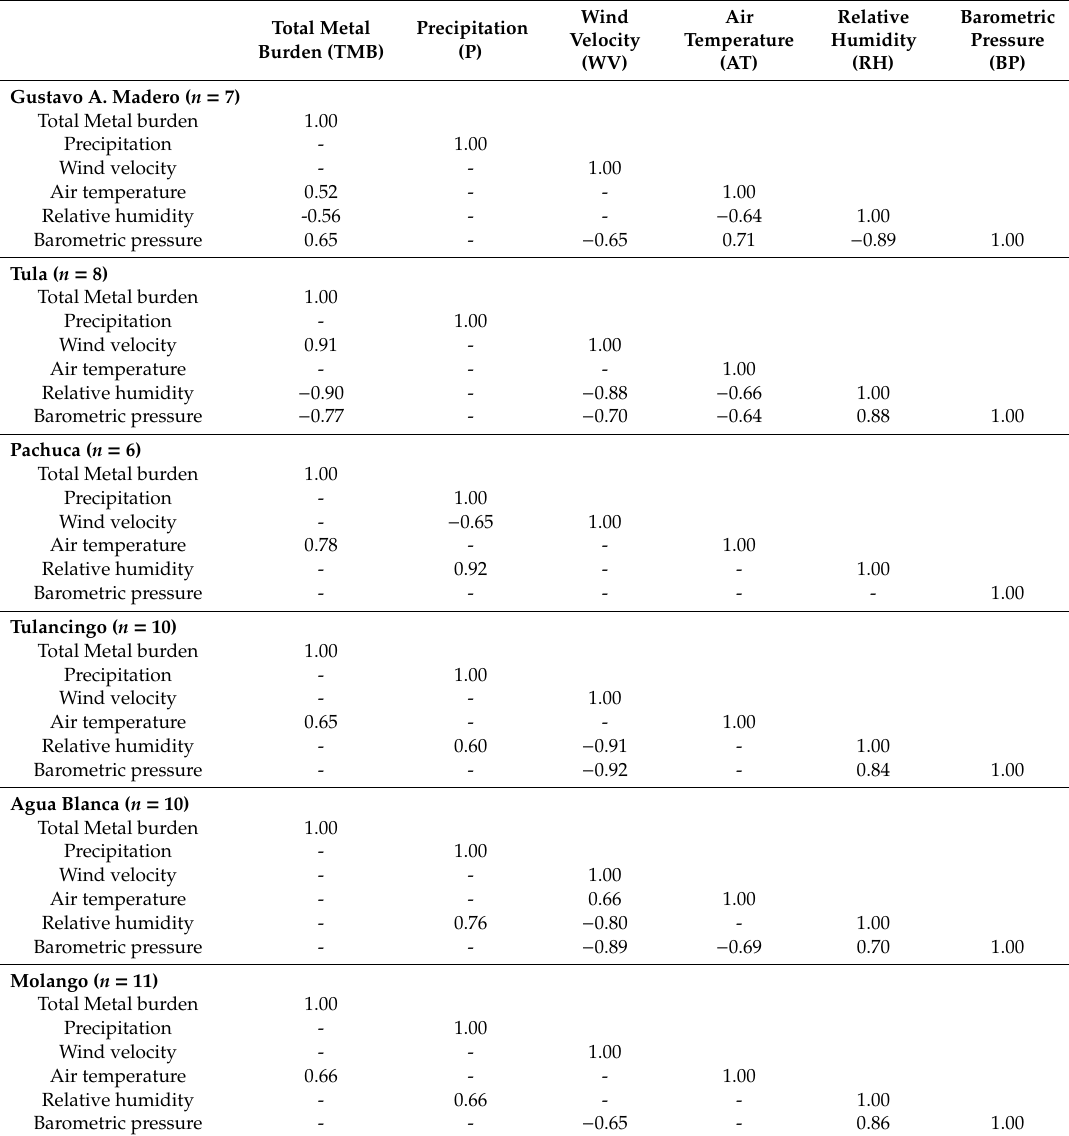
Table 3. Correlation matrix of total metal burdens and meteorological conditions for each